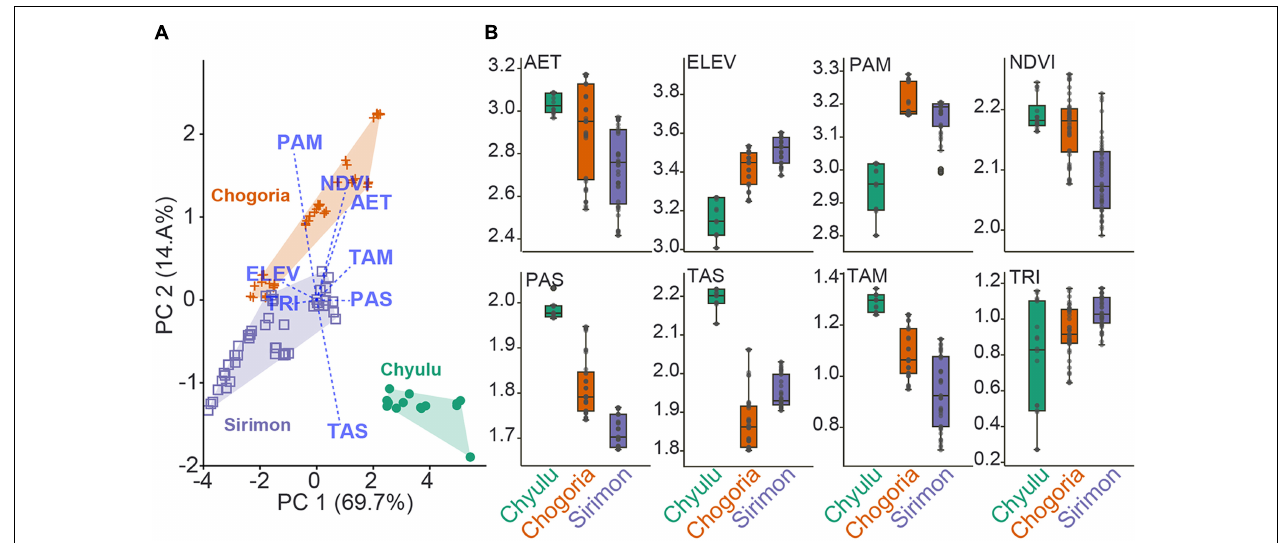
FIGURE 5 | The environmental characterization of Mt. Kenya and Chyulu based on the predictors used in the study. (A) Scatter plot of the first two principal component analysis (PCA) axes illustrating differences between elevational gradients. (B) Boxplots comparing individual predictor averages between the sites.